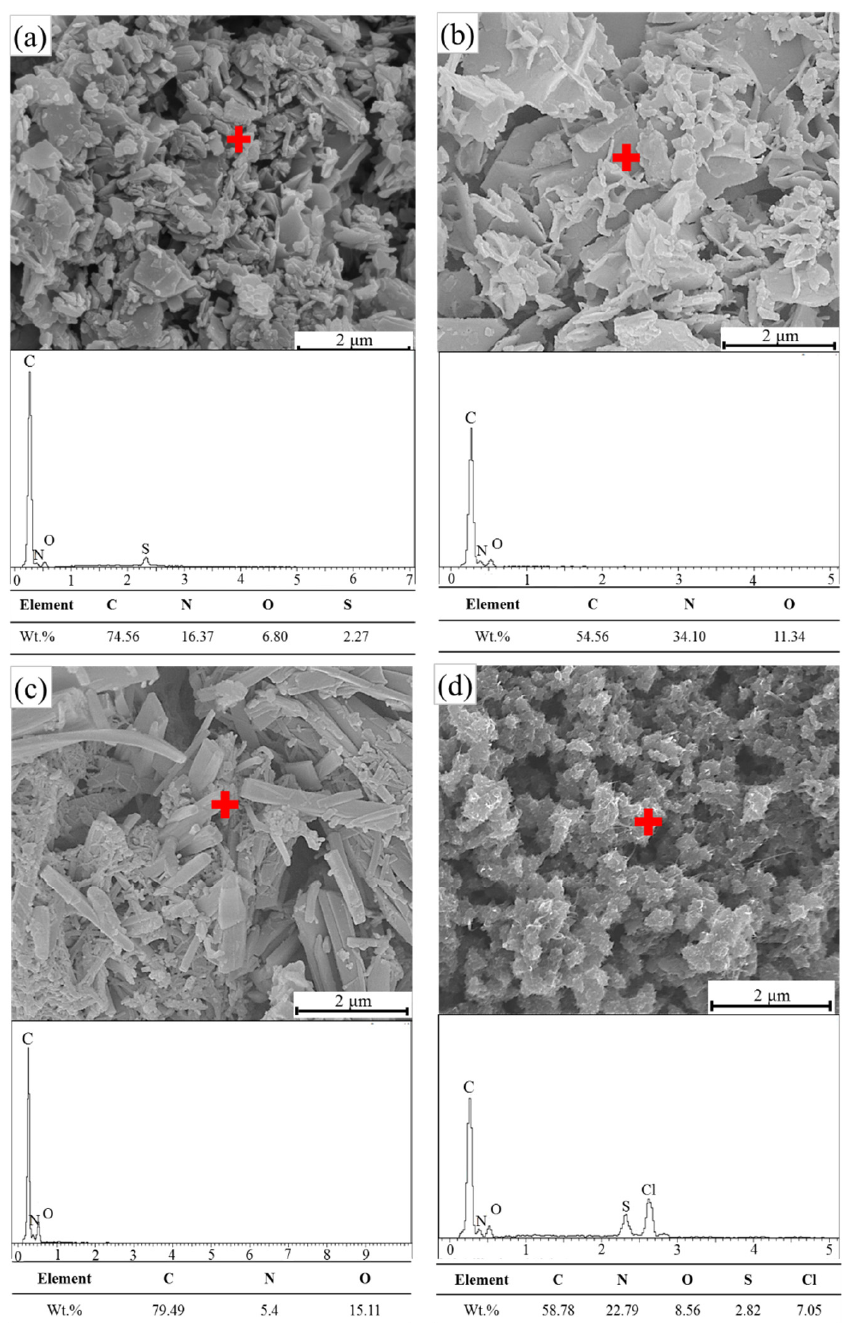
Figure 6. FE-SEM patterns and EDS point analysis of ( a ) PANI-PTSA, ( b ) PANI-CSA, ( c ) PANI-acetic acid and ( d ) PANI-HCl.